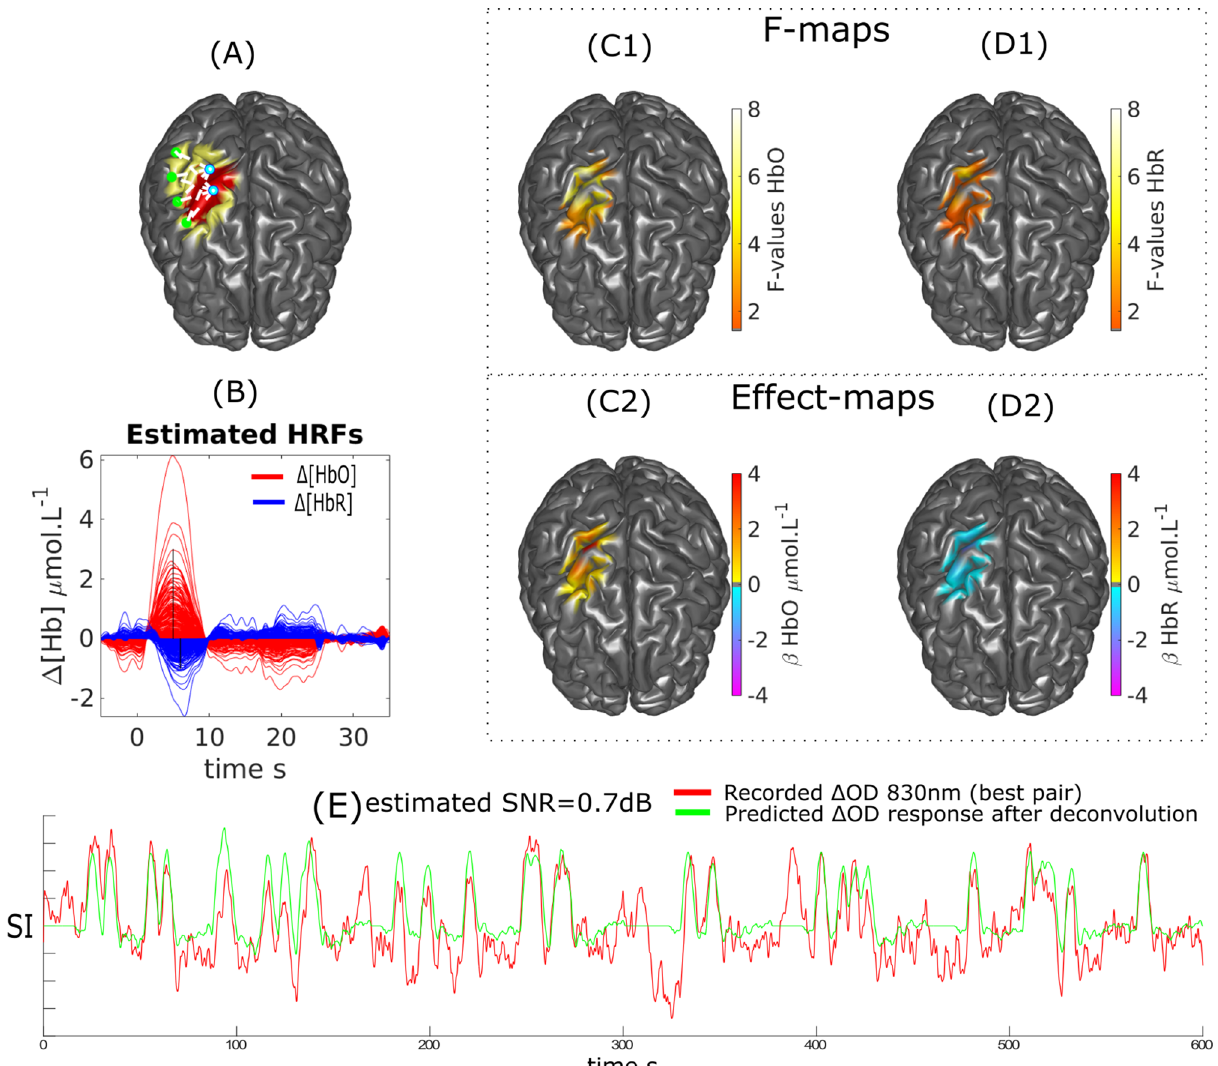
Figure 9. DOT reconstruction and HRF deconvolution for a finger opposition task on Subject 1. ( A ) Montage, ROI (red) and FOV (yellow). ( B ) Estimated HRF time courses. ( C1 , C2 ) (cid:31) [ HbO ] : Thresholded F-map ( α = 0.05 , Bonferronni corrected) and associated effect size map estimated at TTP 1 = 5 s. ( D1 , D2 ) (cid:31) [ HbR ] : Thresholded F-map ( α = 0.05 , Bonferronni corrected) and associated effect size map estimated at TTP 1 = 6 s. 830 ( E ) Most sensitive (cid:31) OD pair over the target ROI and corresponding predicted response after deconvolution (at the sensor level) with the binary stimuli